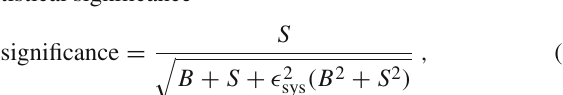
Fig. 4 Toptworows:Colliderreachforthe2 1 / 2 ofmass M χ = 1 . 1TeV √ √ s = 3 TeV (left) and s = 6 TeV (right). Upper row: Combined and reachforMIM(mono- γ +mono- W )asafunctionoftheluminosity L for different value of the expected systematic uncertainties parametrized by (cid:18) sys : 1% (purple), 0 . 1% (cyan), 0 (green). The red lines show the benchmark luminosity following Eq. (20). Lower row: Reach of DT for varying lifetime of the charged track. The red vertical line shows the benchmark lifetime for EW splitting. The blue and orange curves